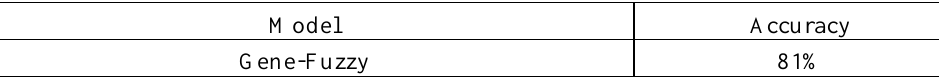
Accuracy Value for Gene-Fuzzy Test